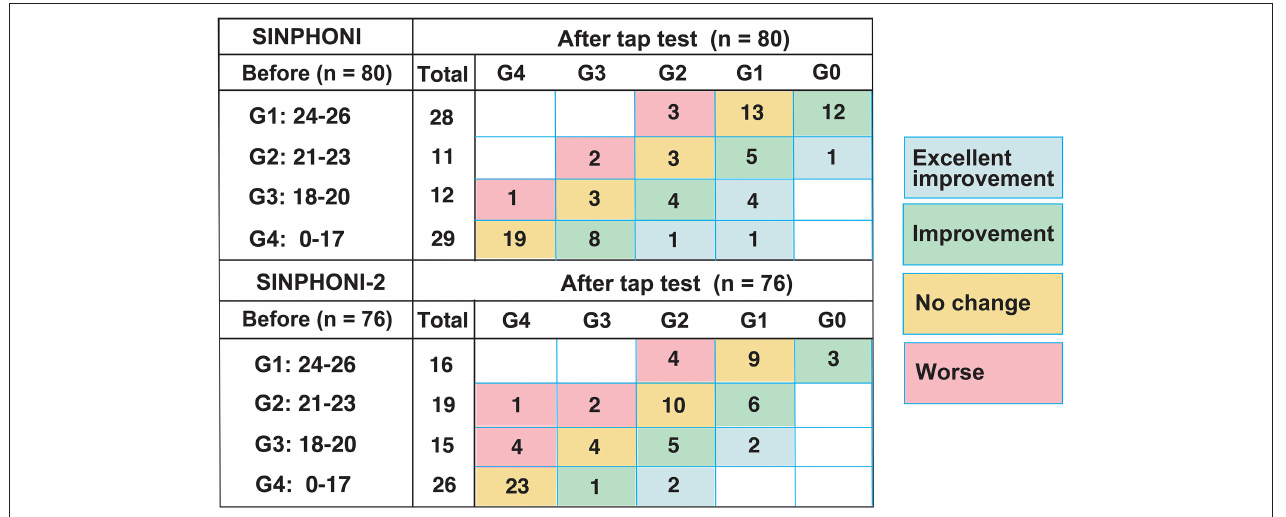
FIGURE 3 | MMSE score changes after the tap test. Distribution of dementia severity grades before and after the tap test, according to MMSE scores in SINPHONI-1 and SINPHONI-2. Numbers in each box indicate the number of patients. Blue, green, and red boxes indicate patients in “excellent improvement,” “improvement,” and “worse” groups. Spearman’s rank correlation coefficient and p -value between before and after the tap test are ρ : 0.83 ( p < 0.001) in SINPHONI-1 and ρ : 0.85 ( p < 0.001) in SINPHONI-2, respectively. G, grade; SINPHONI, study of idiopathic normal pressure hydrocephalus on neurological improvement.